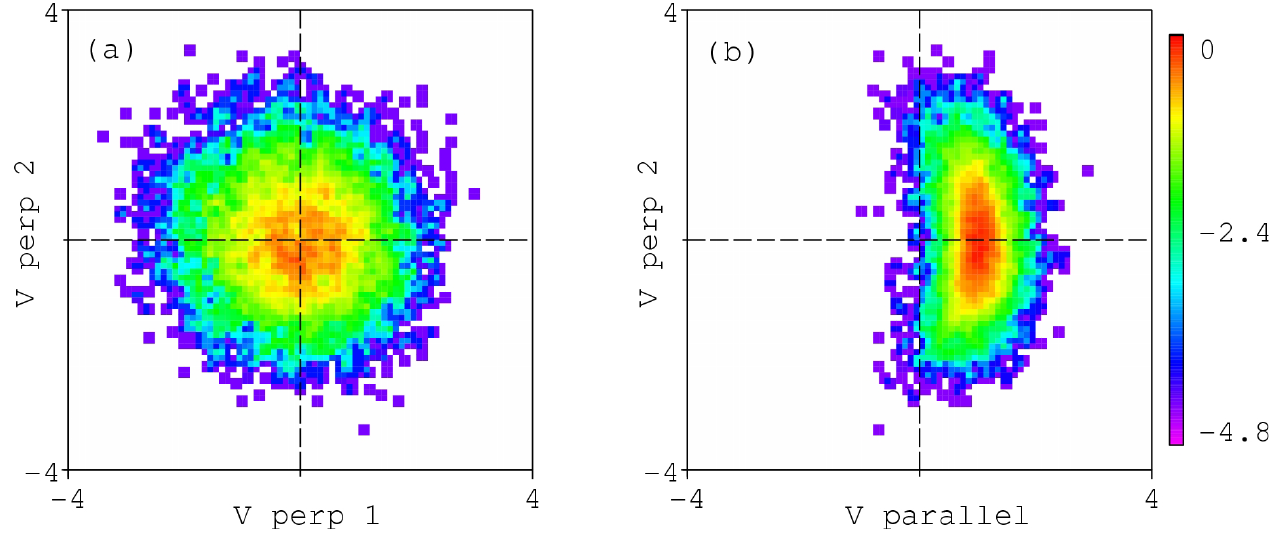
Fig. 7. Color-coded phase space density of crossing particles (see text): (left) in the perpeendicular plane (right) in the parallel-perpendicular plane.